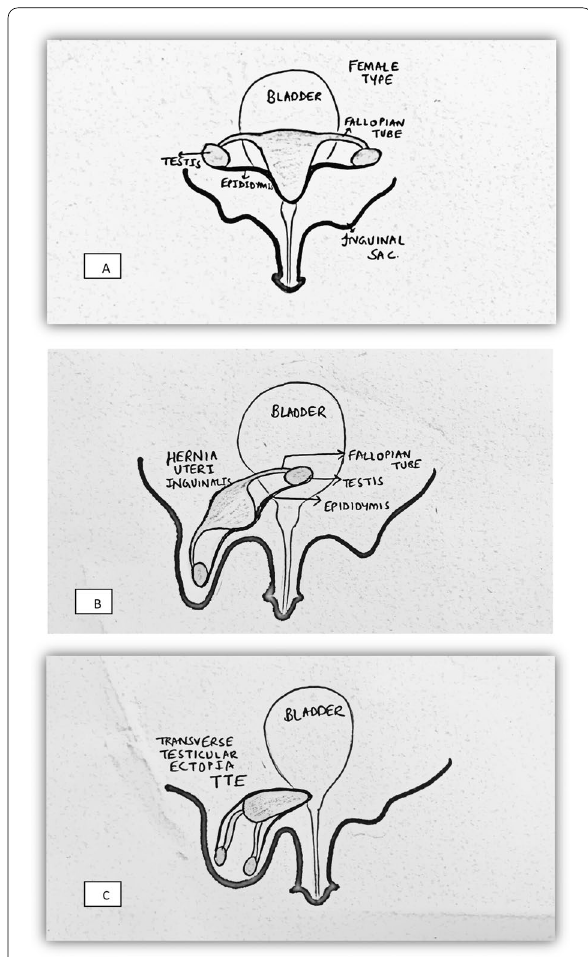
Fig. 5 A Female form is characterized by bilateral cryptorchid testes and uterus fixed to the pelvis with bilateral testes attached to the round ligaments on either side. B Male form is characterized by unilateral cryptorchid testis and contralateral inguinal hernia with testis and fallopian tube of the contralateral side in the sac. C Transverse testicular ectopia in which two testes are visualized in the same hernia sac along with the uterus and uterine